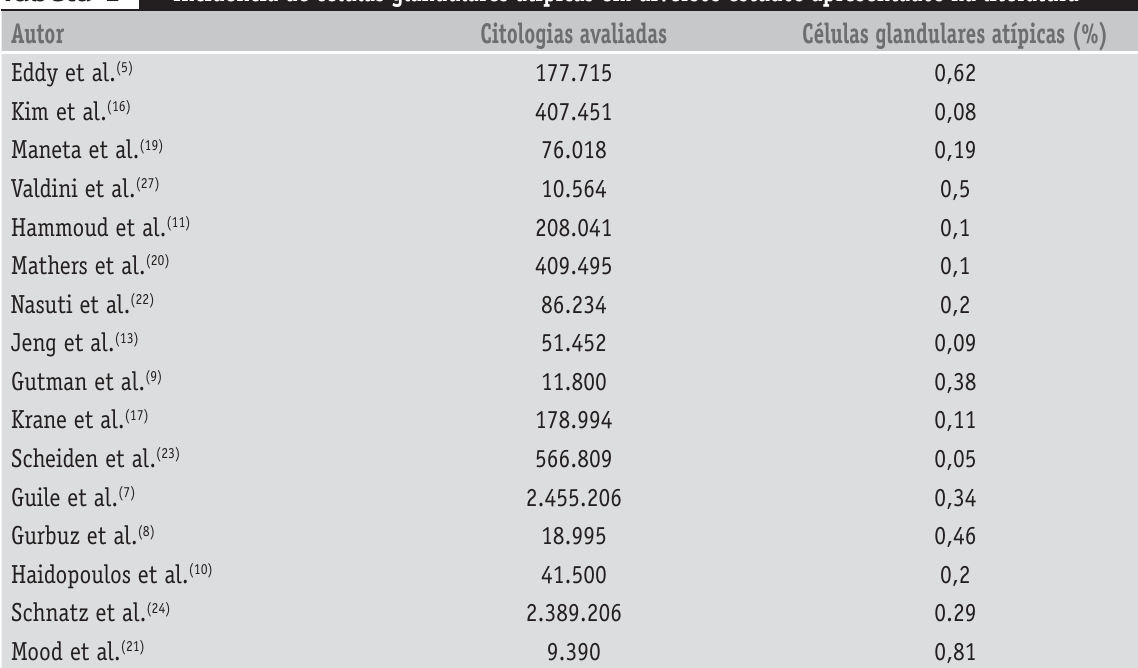
Signifi cado clínico A presença de anormalidades glandulares à citologia pode representar amplo espectro de anormalidades à his- tologia defi nitiva. As alterações histológicas encontradas po- deriam variar desde condições benignas ou reativas (como pólipos endocervicais e endometriais, metaplasia tubária, endometriose cervical, hiperplasia microglandular,